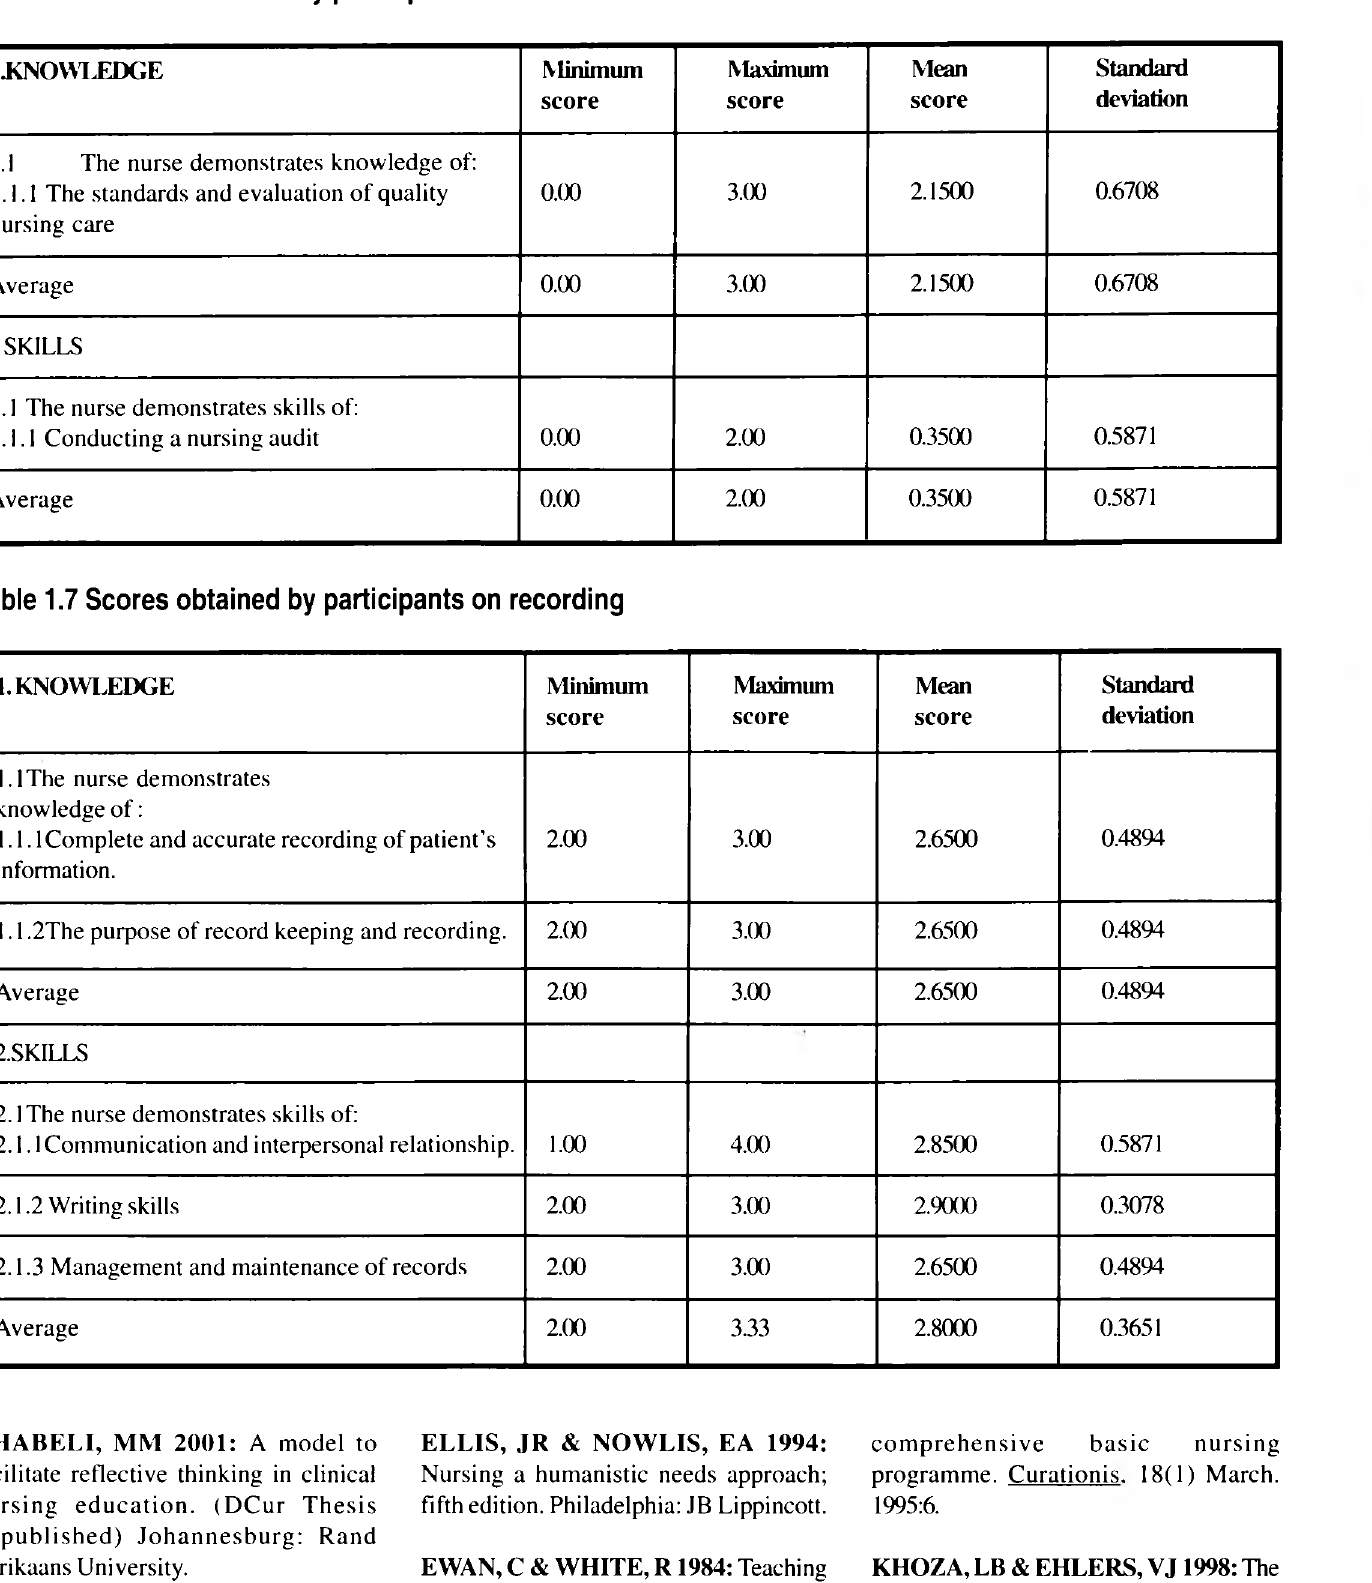
Table 1.6: Scores obtained by participants on evaluation